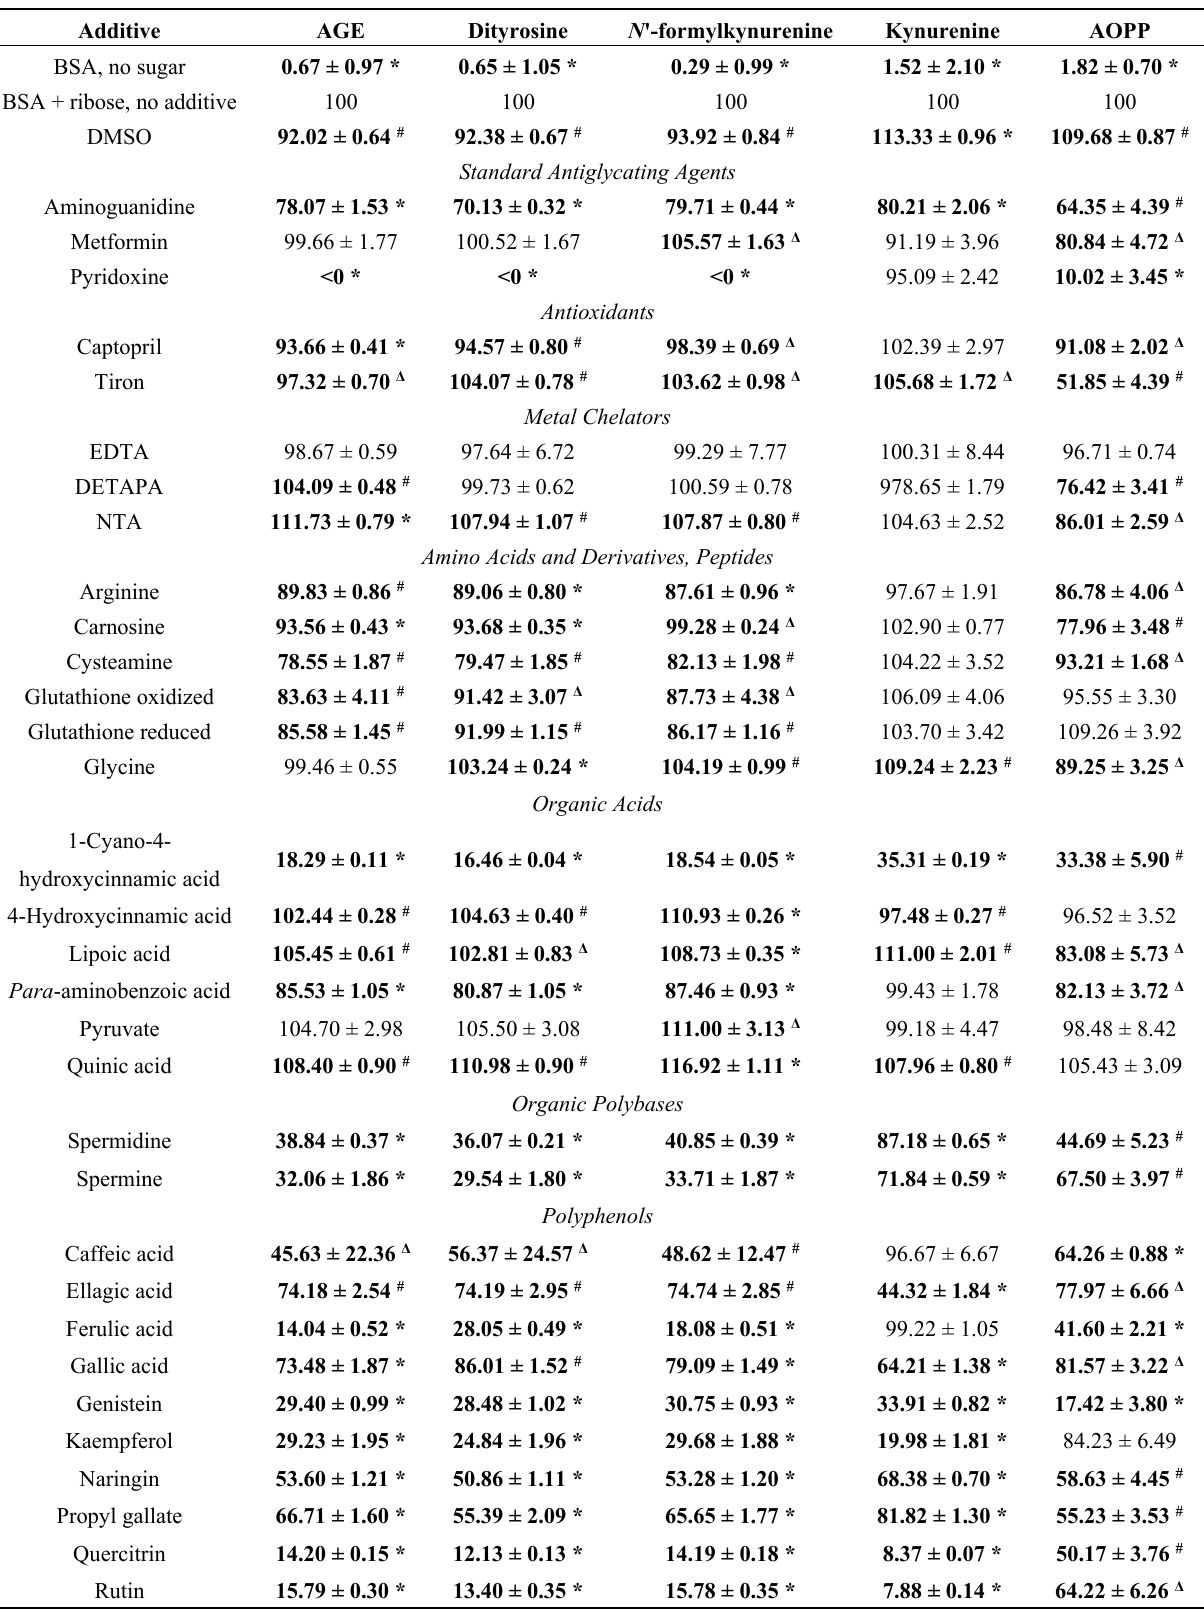
Table 3. The effect of various additives (1 mM) on the extent of the glycoxidation of BSA induced by ribose (0.5 M), estimated with fluorometric parameters. Δ p < 0.05, # p < 0.01, * p < 0.001 (paired Student’s t